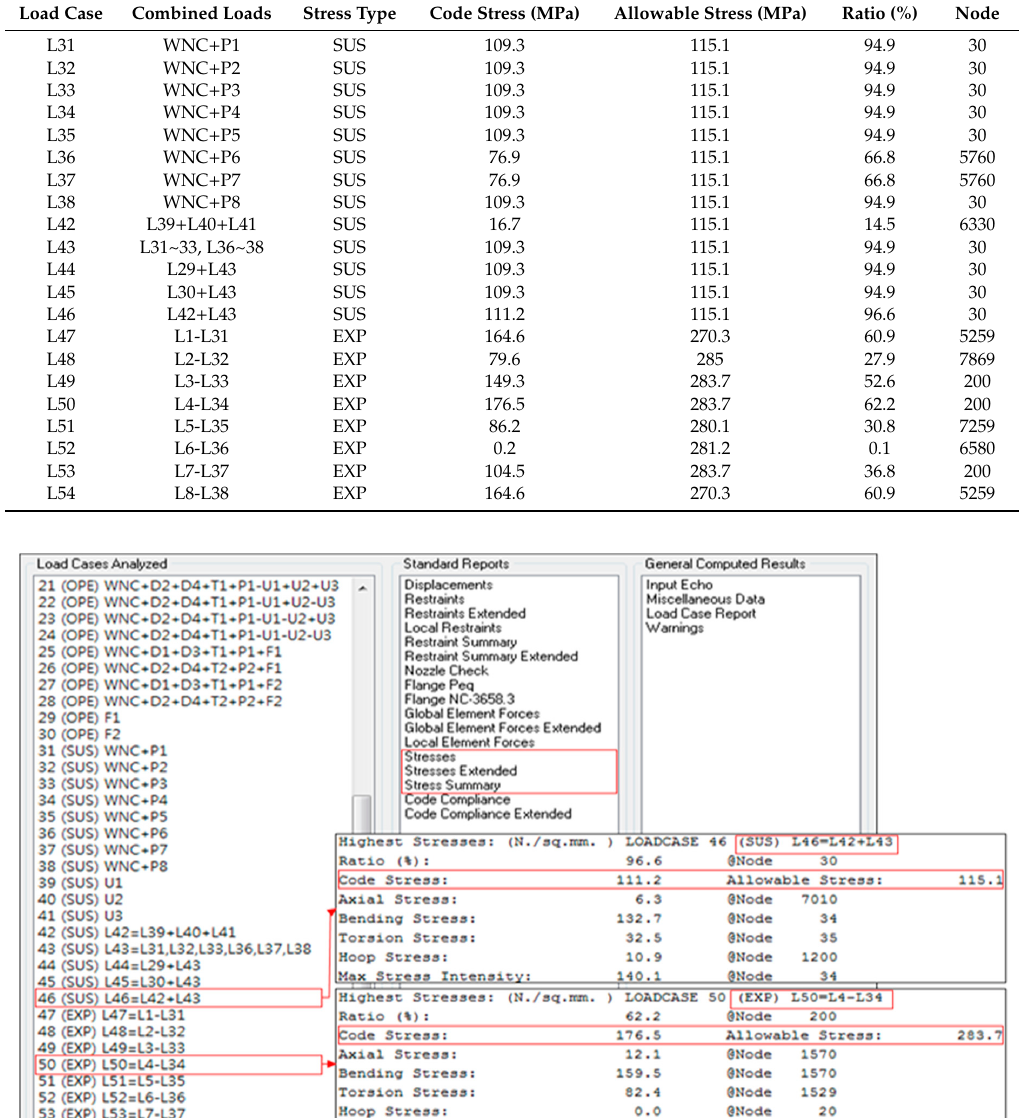
Table 8. Maximum stresses of load cases.